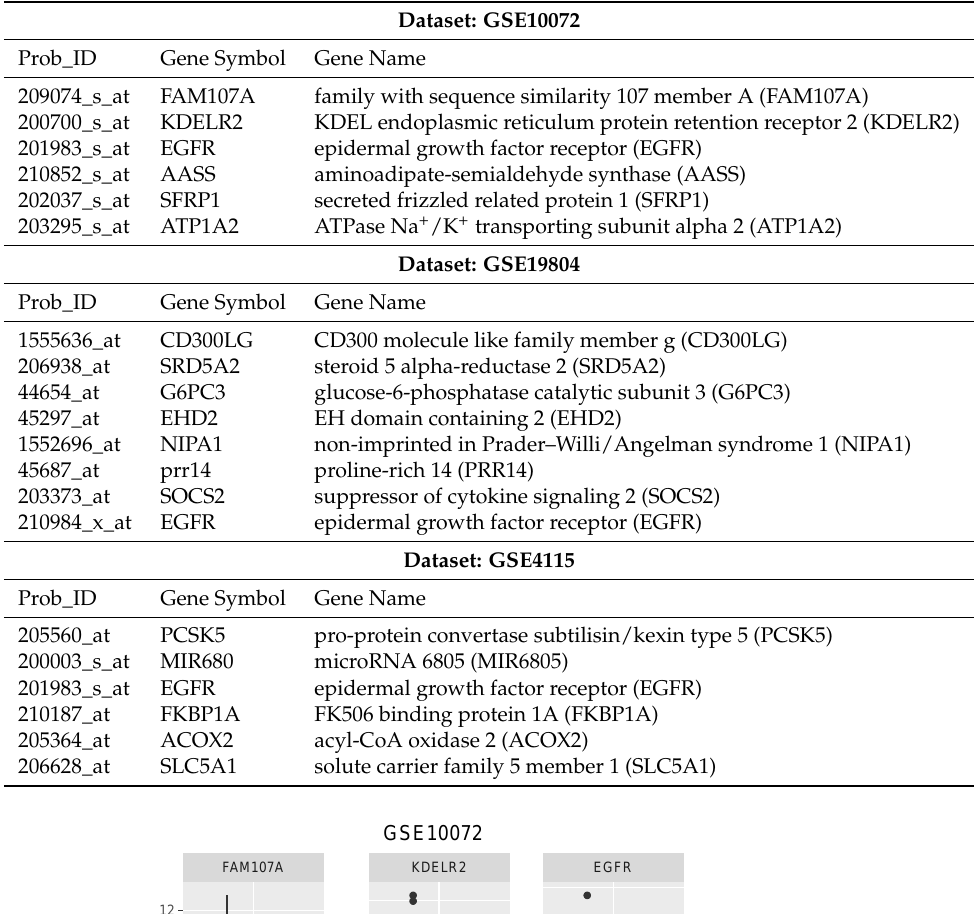
Table 4. The genes selected by L 1/2 for different datasets.